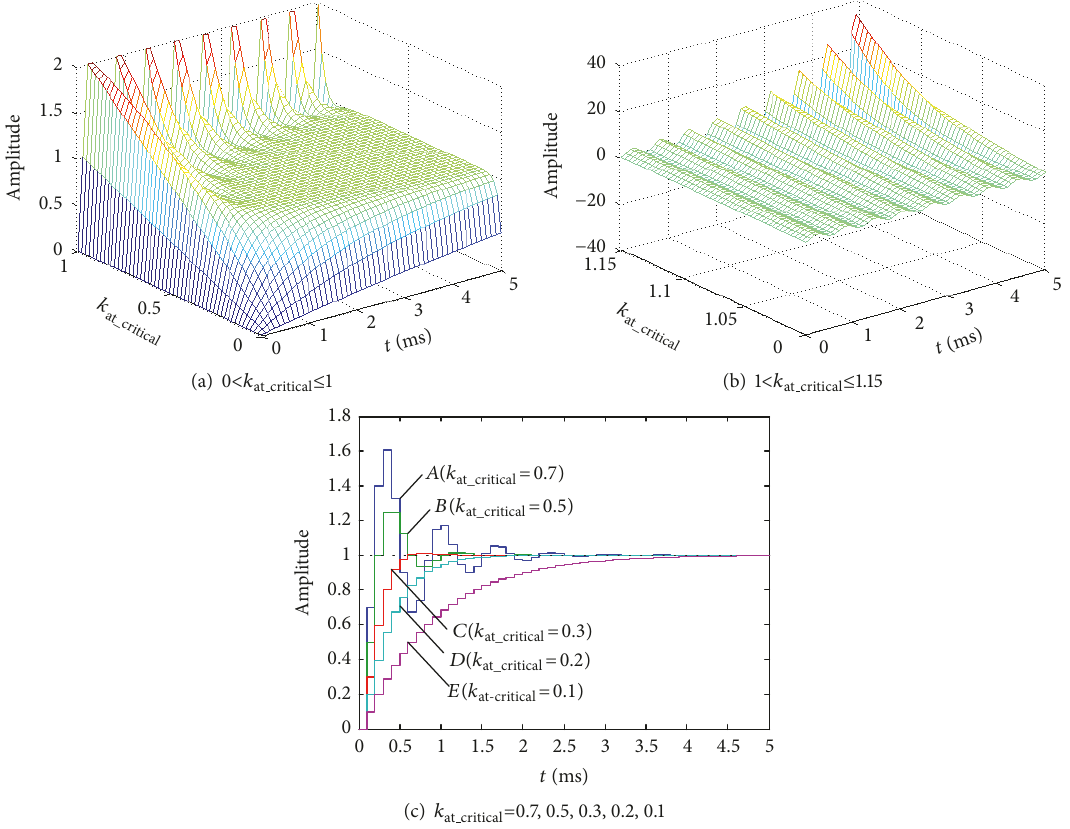
Figure 8: Single update PWM system response to unit step change with the constant sampling frequency f when 𝑘 changes. at critical